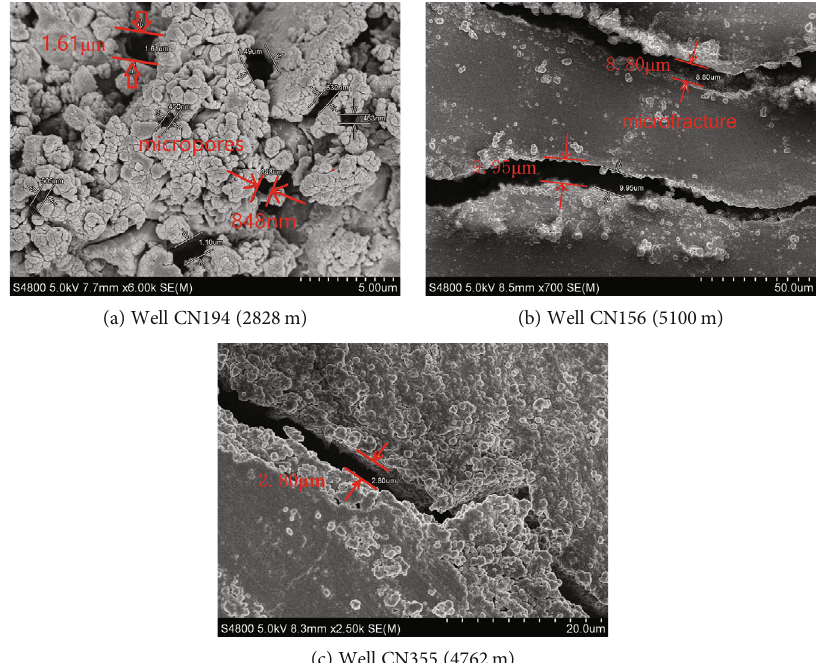
Figure 1: SEM images of rock samples of Longmaxi Formation.